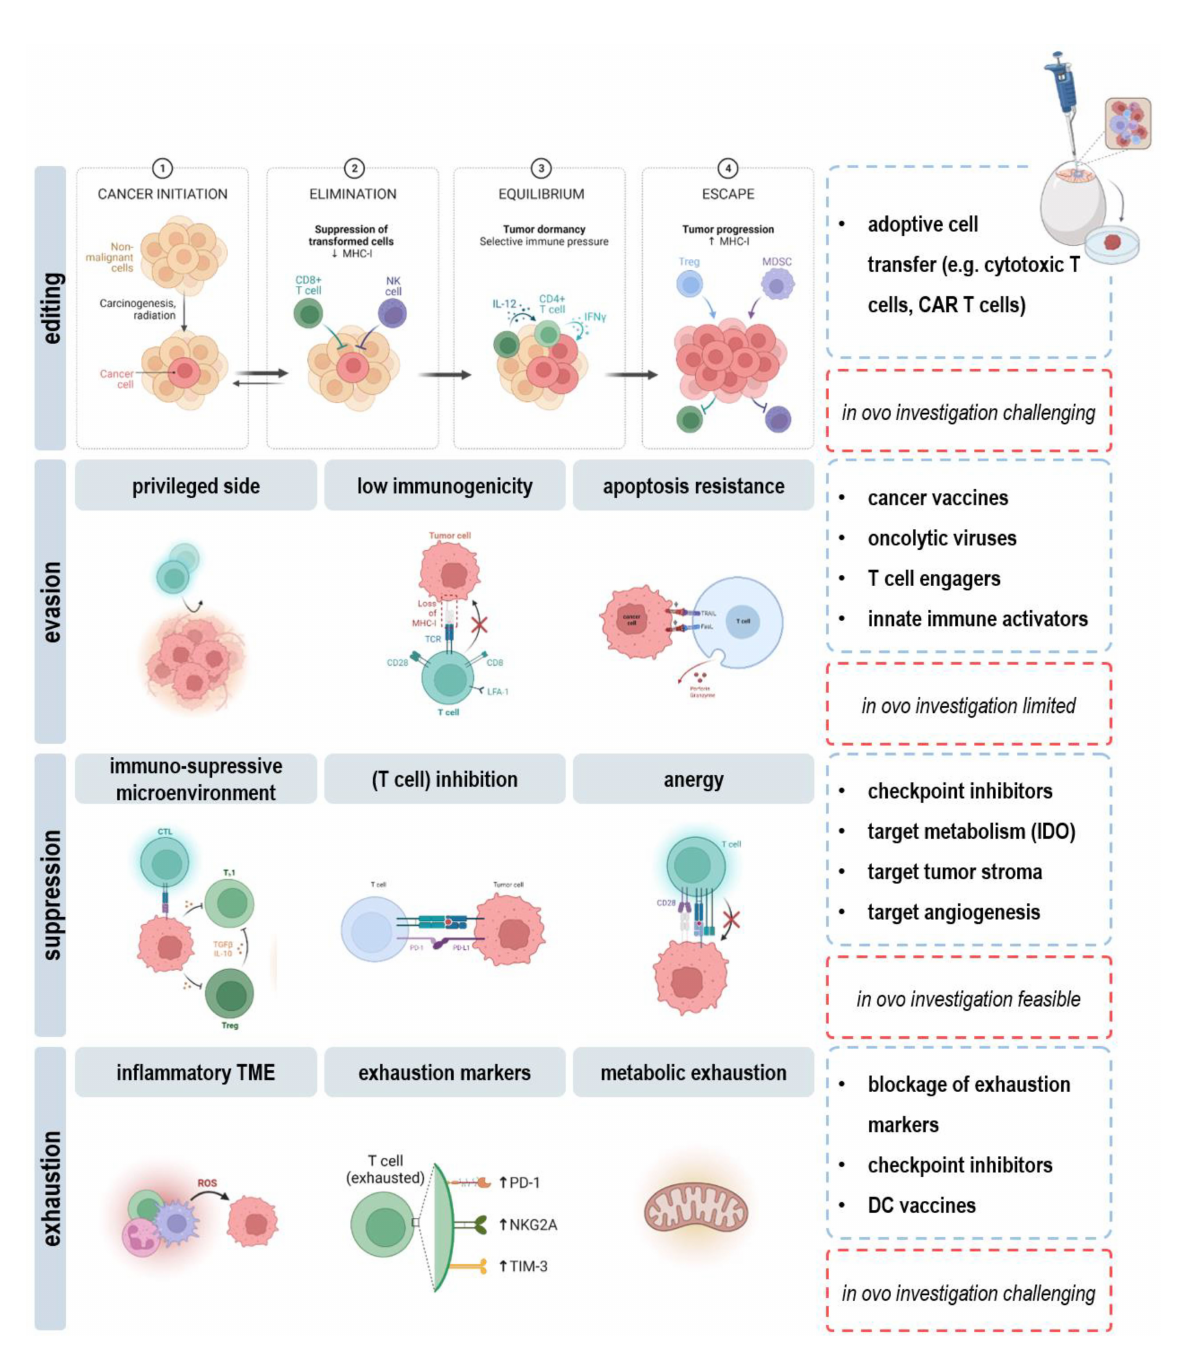
FIGURE 5 Applicability and limitations of the in ovo model in immuno-oncological